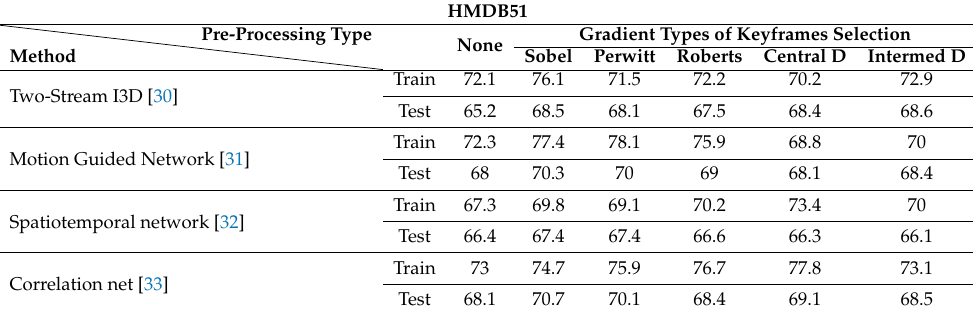
Table 1. Accuracy of the Train and Test data in the HMDB51 dataset versus Gradient types (D—difference).